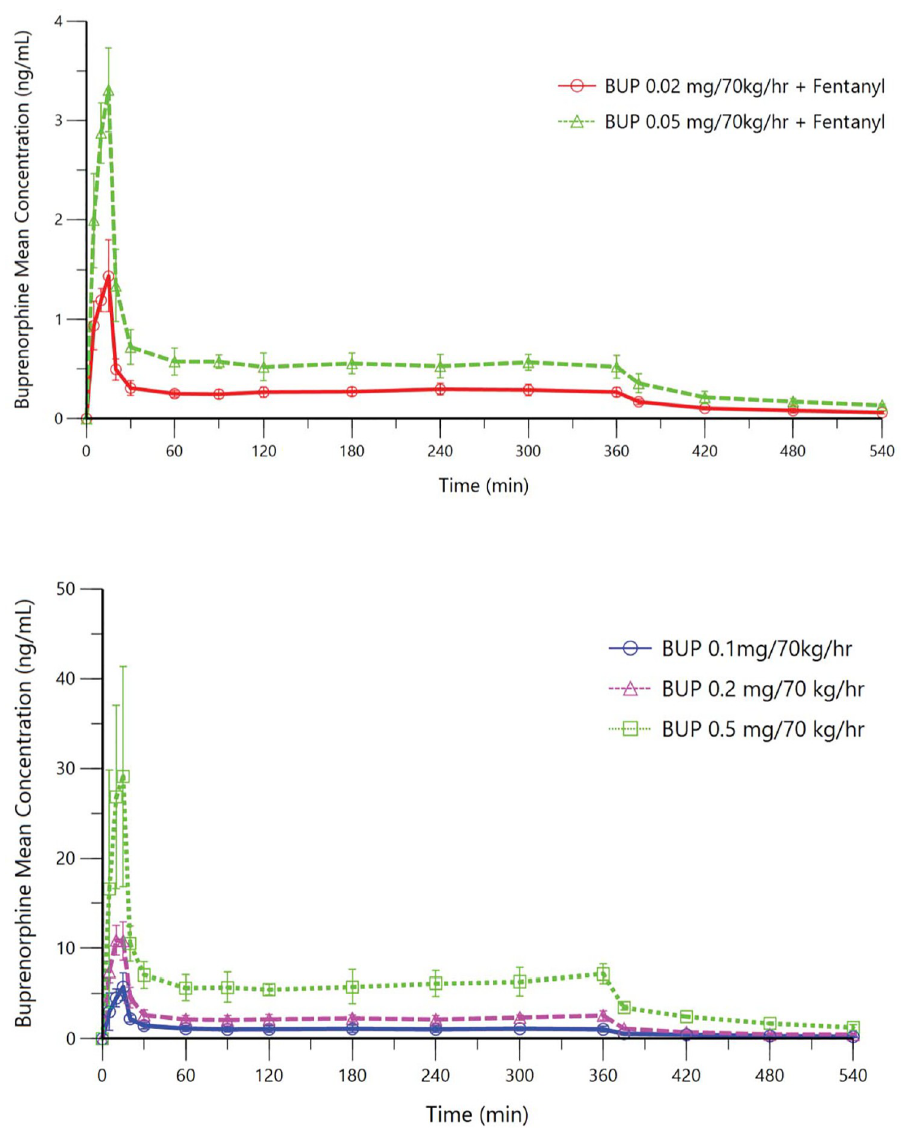
Fig 2. Mean buprenorphine plasma concentration-time curves. Upper panel: Part A, healthy volunteers; Lower panel: Part B, opioid-tolerant patients. In both healthy volunteers and opioid-tolerant patients, a 10-fold higher infusion rate was used over the first 15 minutes to speed attainment of steady-state buprenorphine concentrations at the site of action. Infusions were stopped at 360 min. Steady-state buprenorphine infusion rates are labelled in the